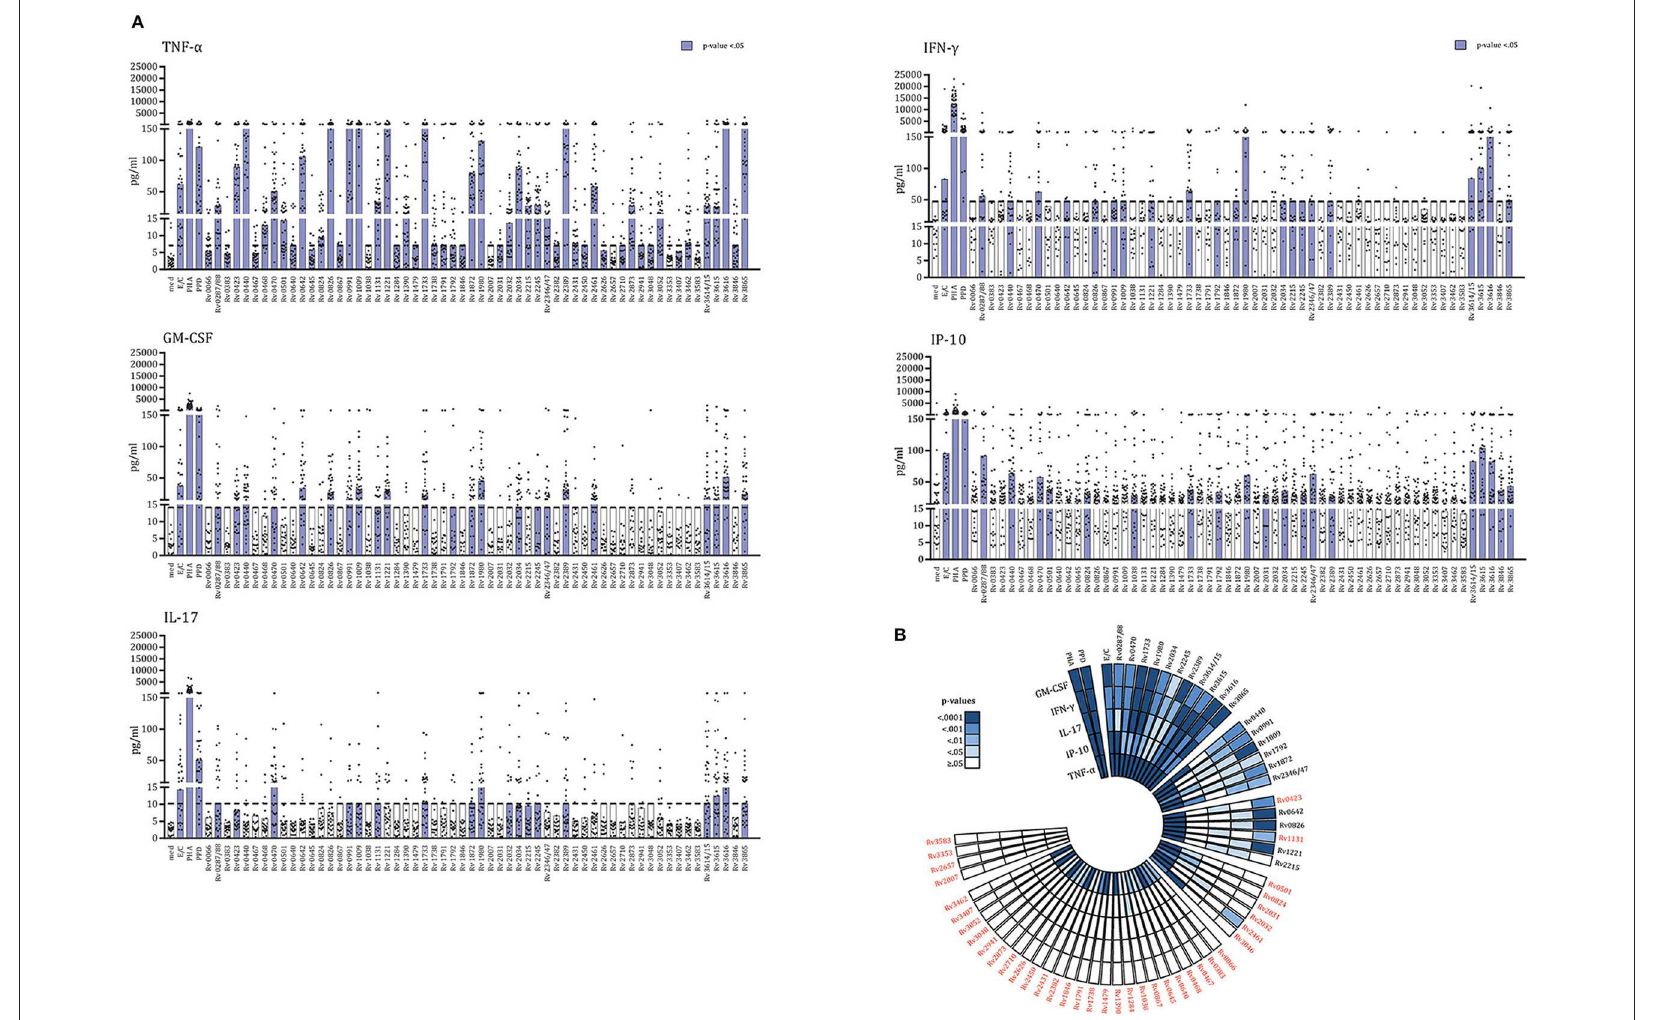
FIGURE 1 | IVE-TB Mtb antigens, Mtb DosR-regulon, and Rpf antigens activate multiple-cytokine-producing blood cells of Mtb exposed subjects. The levels of eight cytokines were measured in diluted whole blood supernatants from a cohort of Mtb exposed individuals ( n = 35) after 6 days stimulation with either IVE-TB, DosR, Rpf (10 µ g/ml), control antigens ESAT6/CFP10 (E/C) (10 µ g/ml), PPD (5 µ g/ml), or the positive control, mitogen PHA (2 µ g/ml). The statistical significance of the differences between cytokine levels in stimulated and unstimulated samples was evaluated by Mann-Whitney U -test with FDR multiple test correction for IL-13, IL-22, IL-17A, IFN- γ , IP-10, IL-10, GM-CSF, IL-32, and TNF- α . (A) Results are shown only for TNF- α , GM-CSF, IP-10, IFN- γ , and IL-17A for which significant differences were found among single Mtb antigens and unstimulated samples. Each dot represents a donor. Bars indicate medians. Purple bars indicate significantly increased responses compared to the unstimulated samples with a p < 0.05 (Mann-Whitney U -test with FDR multiple test correction). (B) The polar histogram displays the different p -values found among single Mtb antigens (or control) and unstimulated samples. Stimuli are ordered clockwise as follows: controls and Mtb antigens grouped according to how many cytokines were induced. These groups of antigens are separated by interruptions of the histogram. In red are indicated Mtb antigens that induced cytokines other than IFN- γ